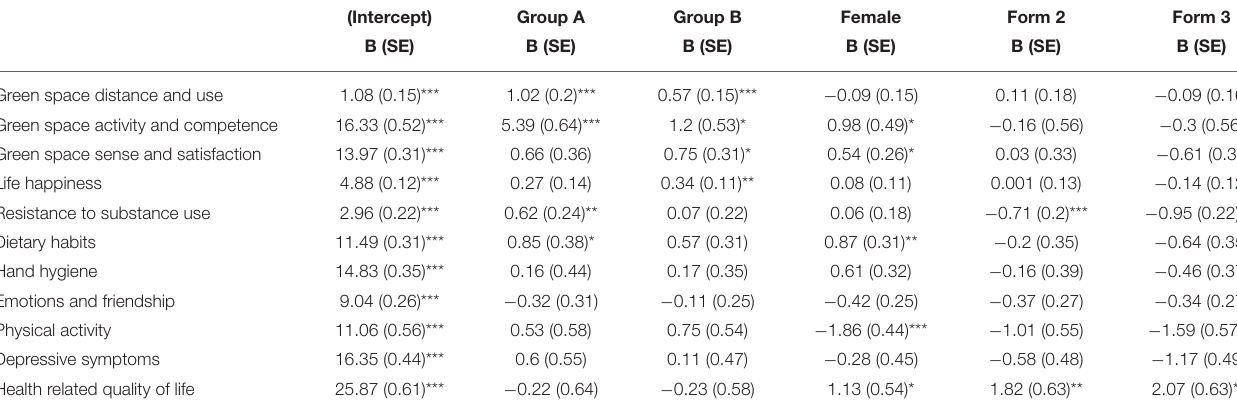
TABLE 3 | Primary and secondary outcomes regressed on group, sex, and school grade. (Intercept) Group A Group